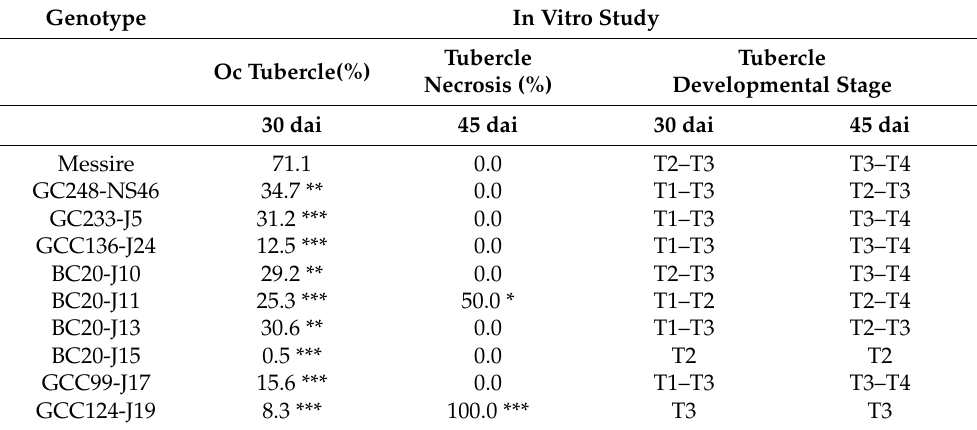
Table 2. Rhizotron study of the responses of pea breeding lines to Orobanche crenata compared to the parental cv.